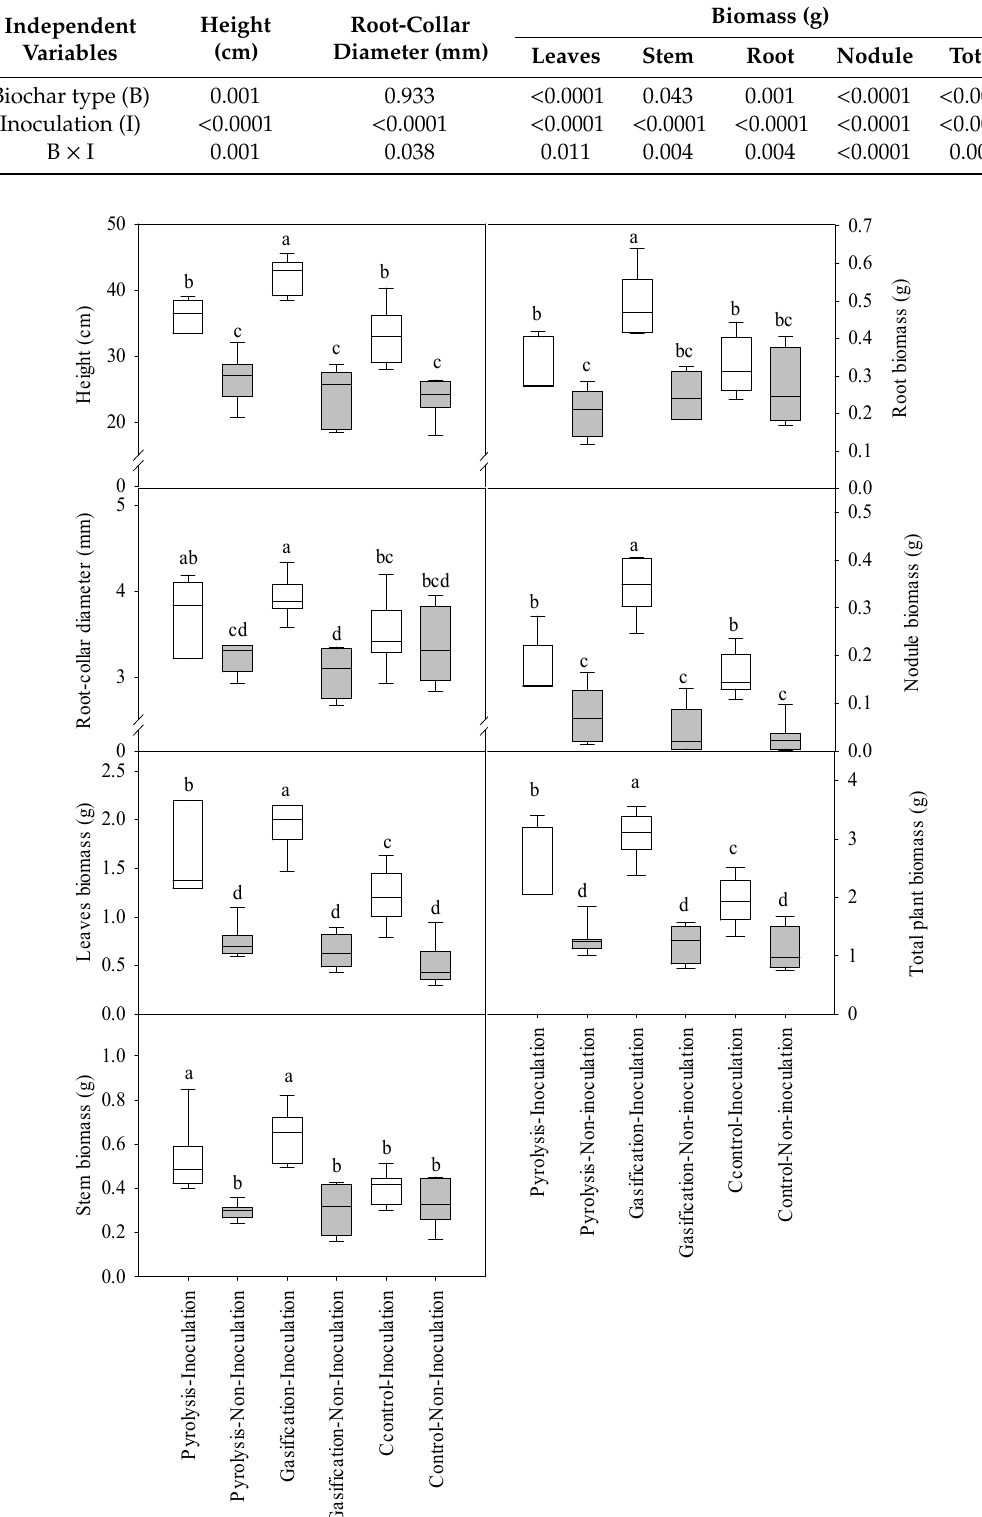
Figure 1. The interaction effect of inoculation × biochar type on height, root-collar diameter, and leaf, stem, root, nodule, and total biomass of black locust seedlings. Different letters indicate significant differences for biochar type × inoculation treatments.